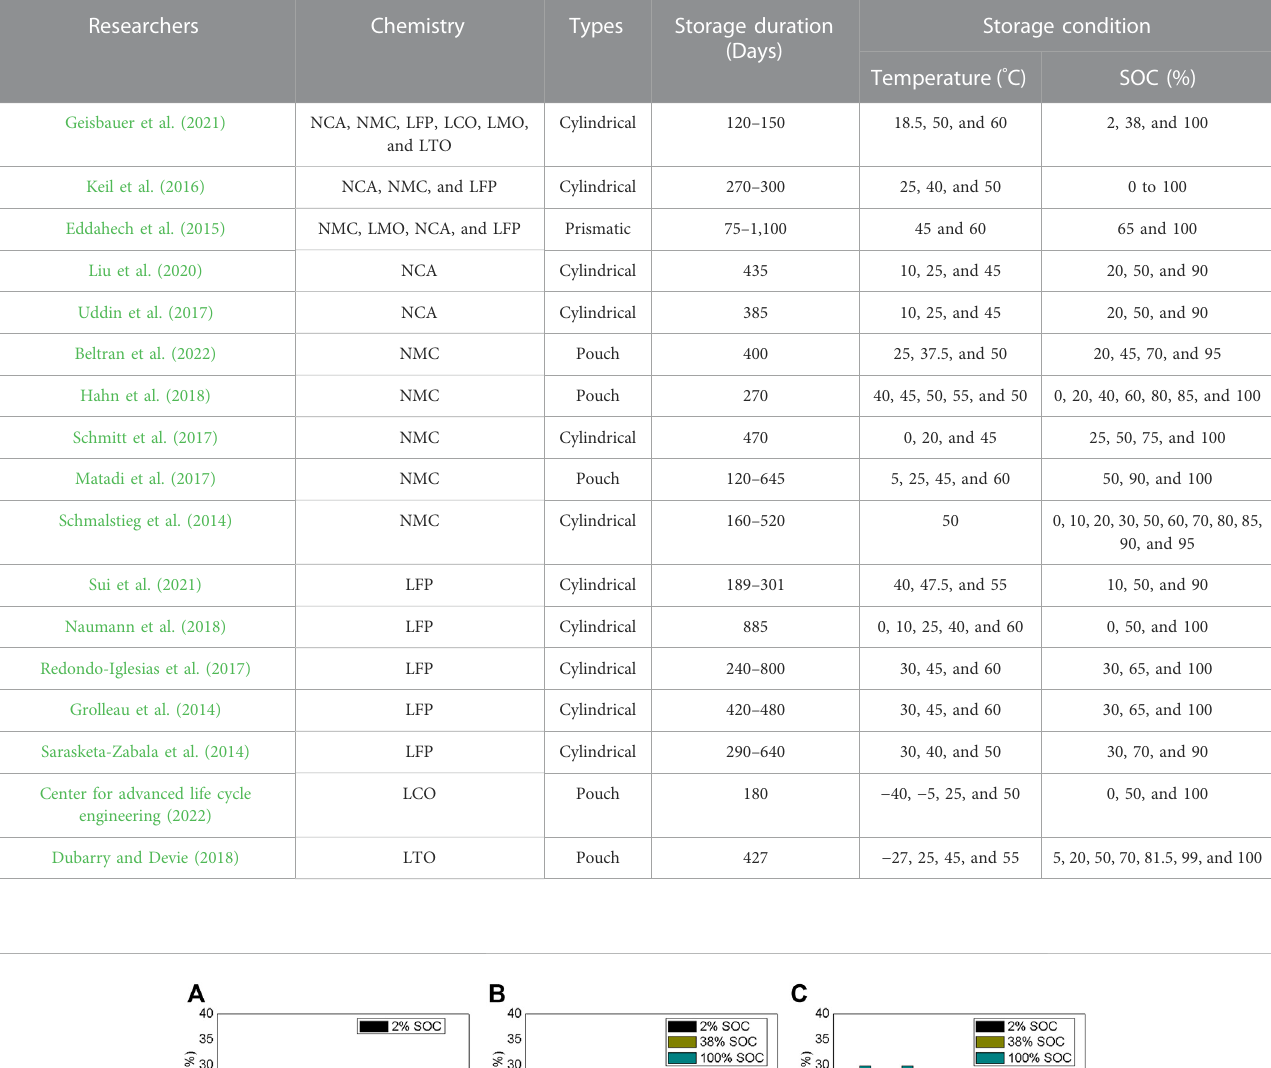
TABLE 2 Overview of calendar aging measurements as reported in the literature.